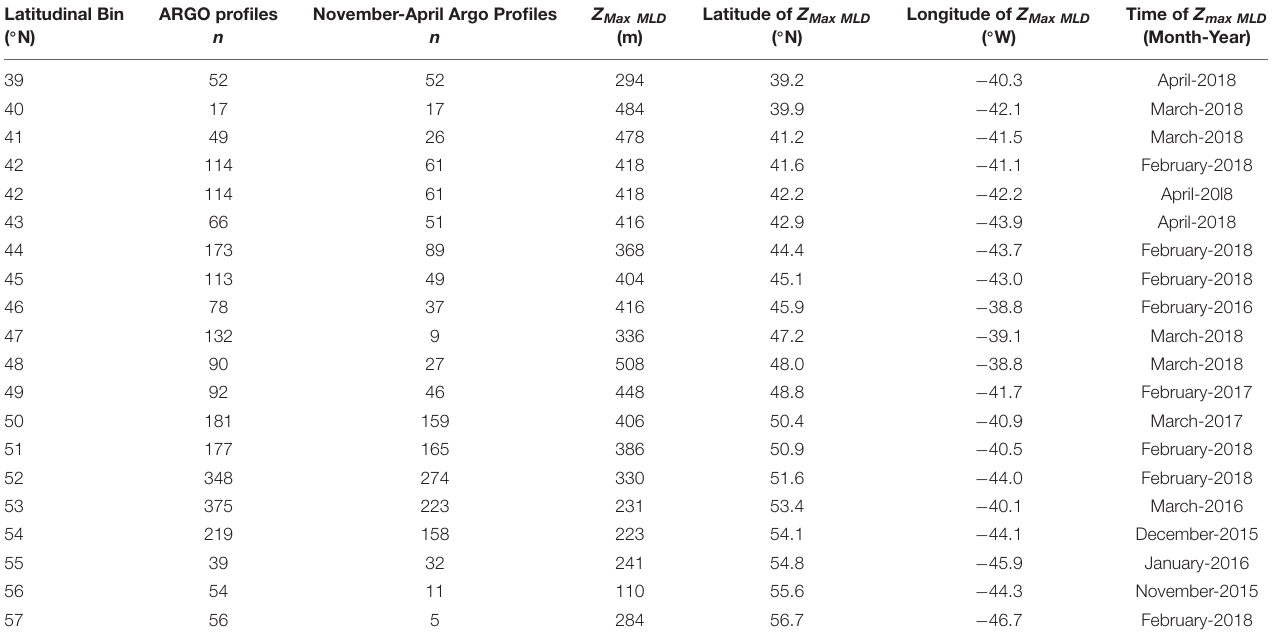
TABLE 1 | Annual maximum mixed layer depths ( Z Max MLD ), estimated from ARGO profiles. Latitudinal Bin